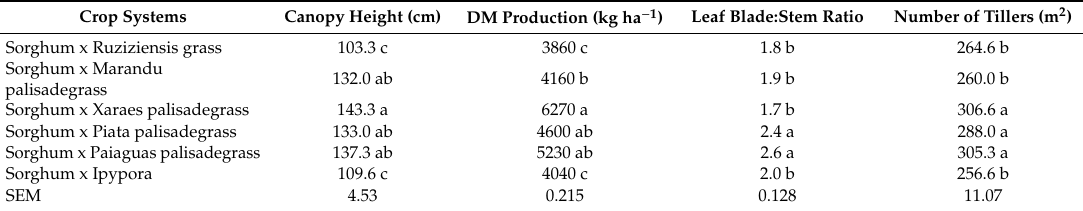
Table 4. Canopy height, dry mass production, leaf blade:stem ratio and number of tillers of Brachiaria forages intercropped of the Brachiaria intercropped with sorghum, evaluated at harvest. Crop Systems Canopy Height (cm) Leaf Blade:Stem Ratio Number of Tillers (m 2